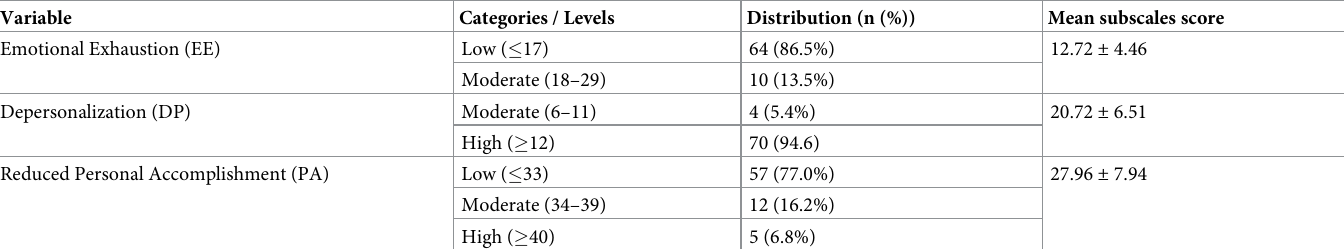
Table 3. Results on the prevalence of burnout amongst respondents.